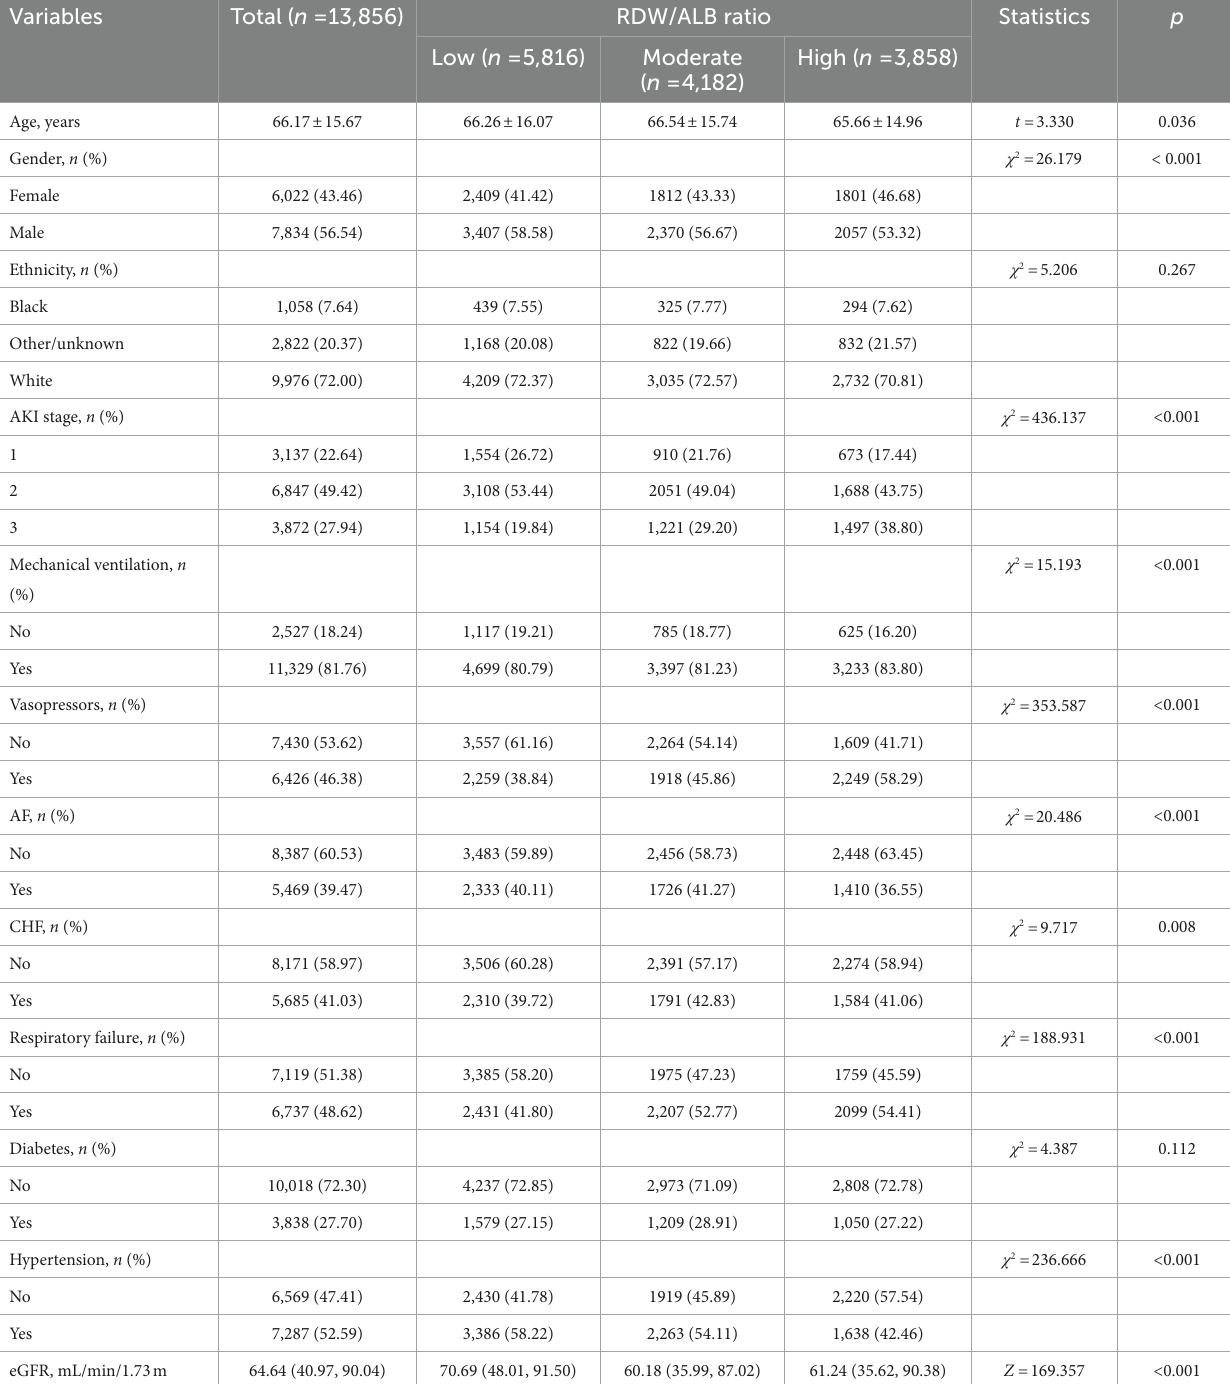
TABLE 1 Characteristics of the study patients divided by RDW/ALB ratios.